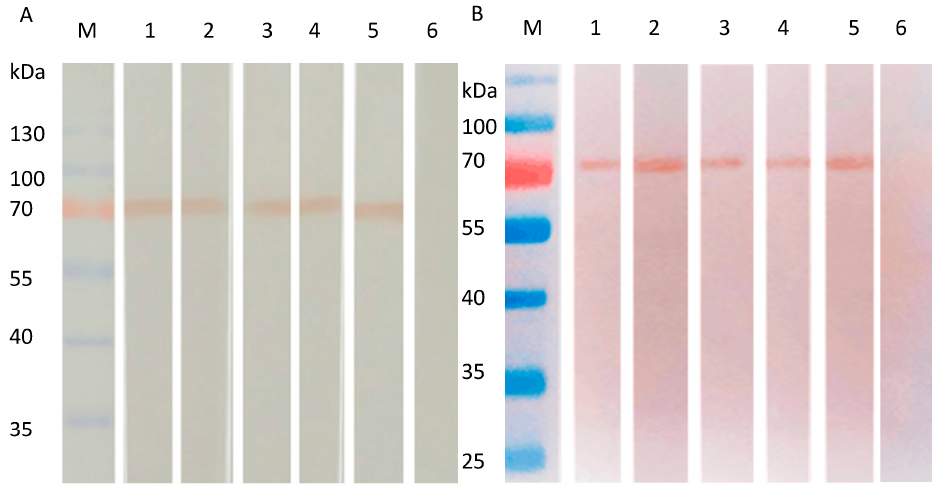
Figure 4. Reactivity of mAbs to HA proteins of SW/GD/04 infected MDCK cells analyzed by Western blotting. HA proteins of SW/GD/04 infected MDCK cells run in SDS-PAGE ( A ) or native PAGE gel ( B ), and then transferred membranes were detected with mAbs by Western blotting. Lane M: protein molecular weight marker; lanes 1, 2, 3, 4, and 5: SW/GD/04-infected MDCK cells run in SDS-PAGE detected by mAbs 8C4, 8C6, 9D6, 8A4, and 8B1, respectively; lane 6: represents mock-infected cells detected by mAbs.